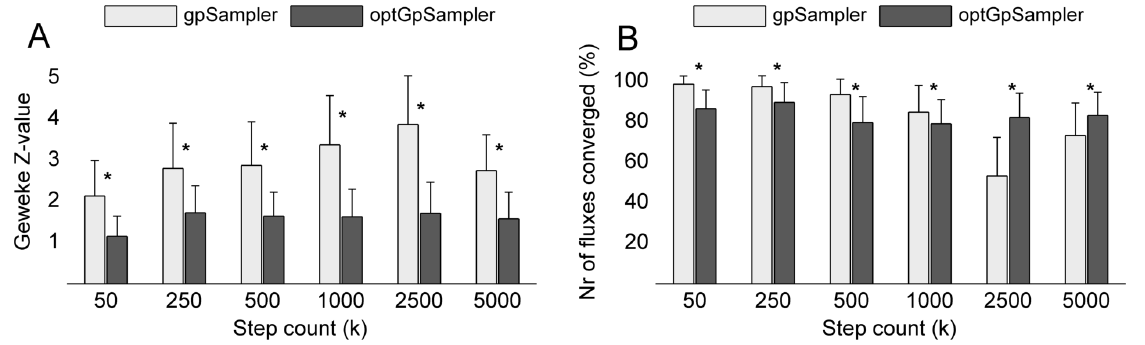
Figure 5. Empirical convergence for E. coli iAF1260. (a) Convergence according to the Geweke diagnostic. (b) Convergence according to the Heidelberger-Welch diagnostic. For both convergence tests, gpSampler ’s performance deteriorates when the step count is increased up to k =2500. Especially the good scores at low values of k seem unrealistic and could indicate convergence towards a non-uniform distribution. Results for optGpSampler seem more stable and more reliable.